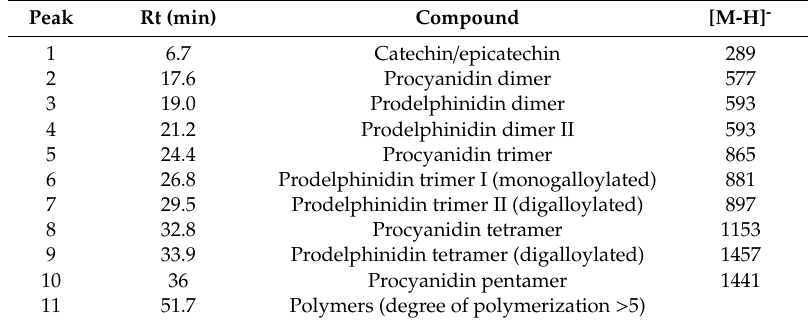
Table 2. Table of identification of proanthocyanidins from brewers’ spent grain extracts by HPLC-MS; Rt—retention